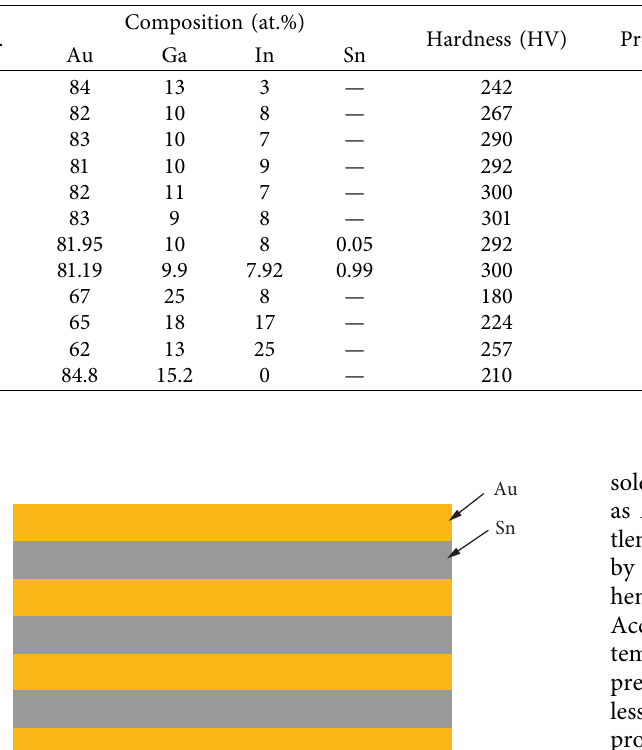
Table 5: Au-Ga-In solders [22].